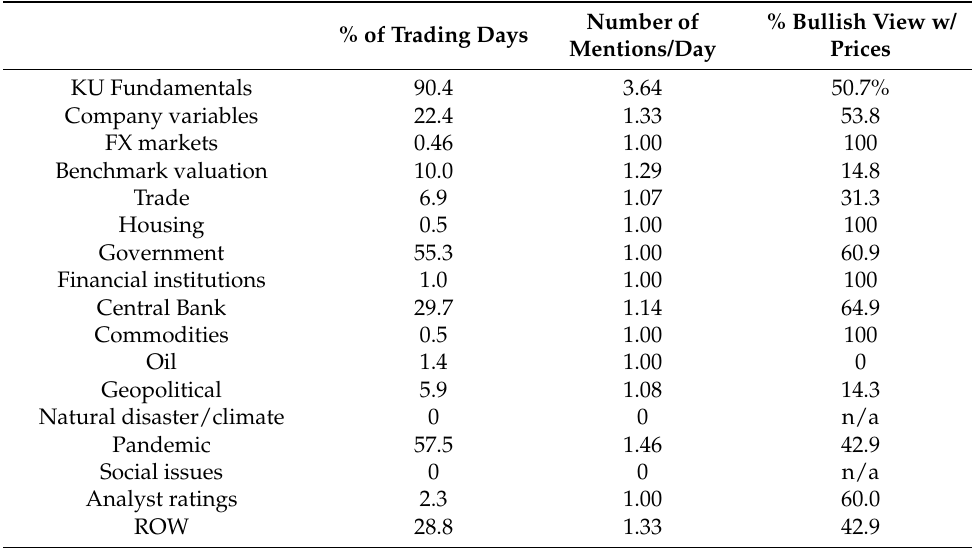
Table 2. Factor frequency of KU events and bullish–bearish